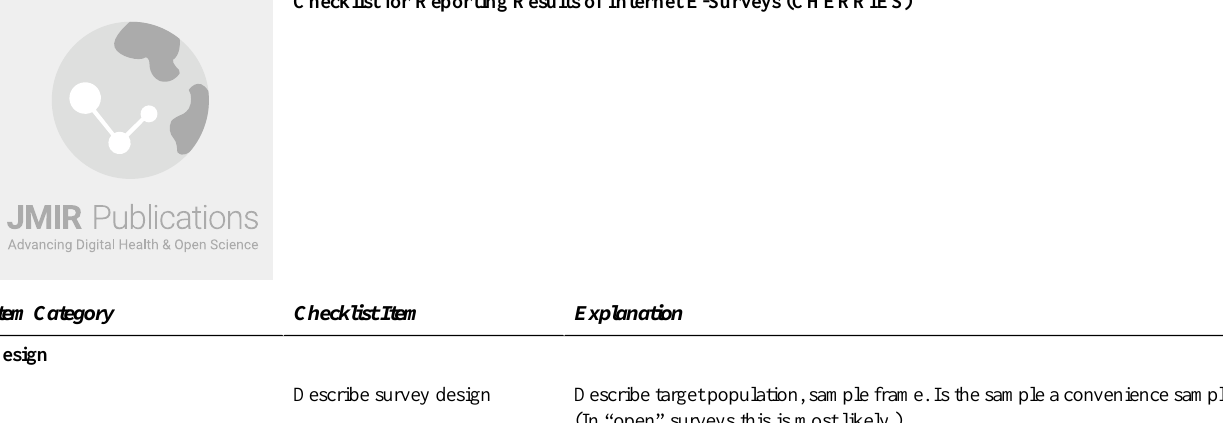
Table 1. Checklist for Reporting Results of Internet E-Surveys (CHERRIES) Checklist for Reporting Results of Internet E-Surveys